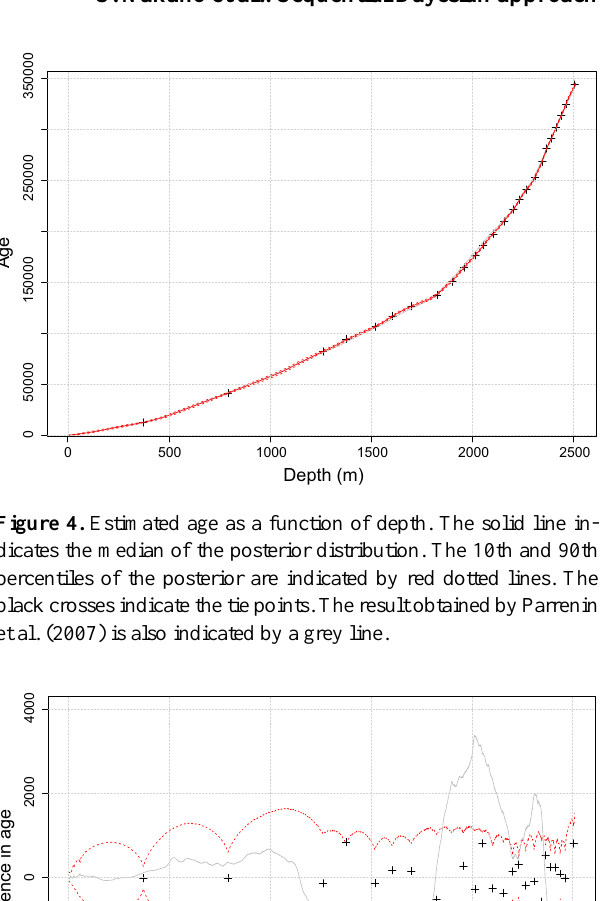
line indicates the estimate using all the tie points. The solid lines indicate the median of the posterior, and the 10th and 90th percentiles are indicated by dotted lines. The difference is remarkable below the depth where the age is 300 000 years. However, the difference was mostly within the uncertainty between the 10th and 90th percentiles. Thus, this difference near the bottom is acceptable.